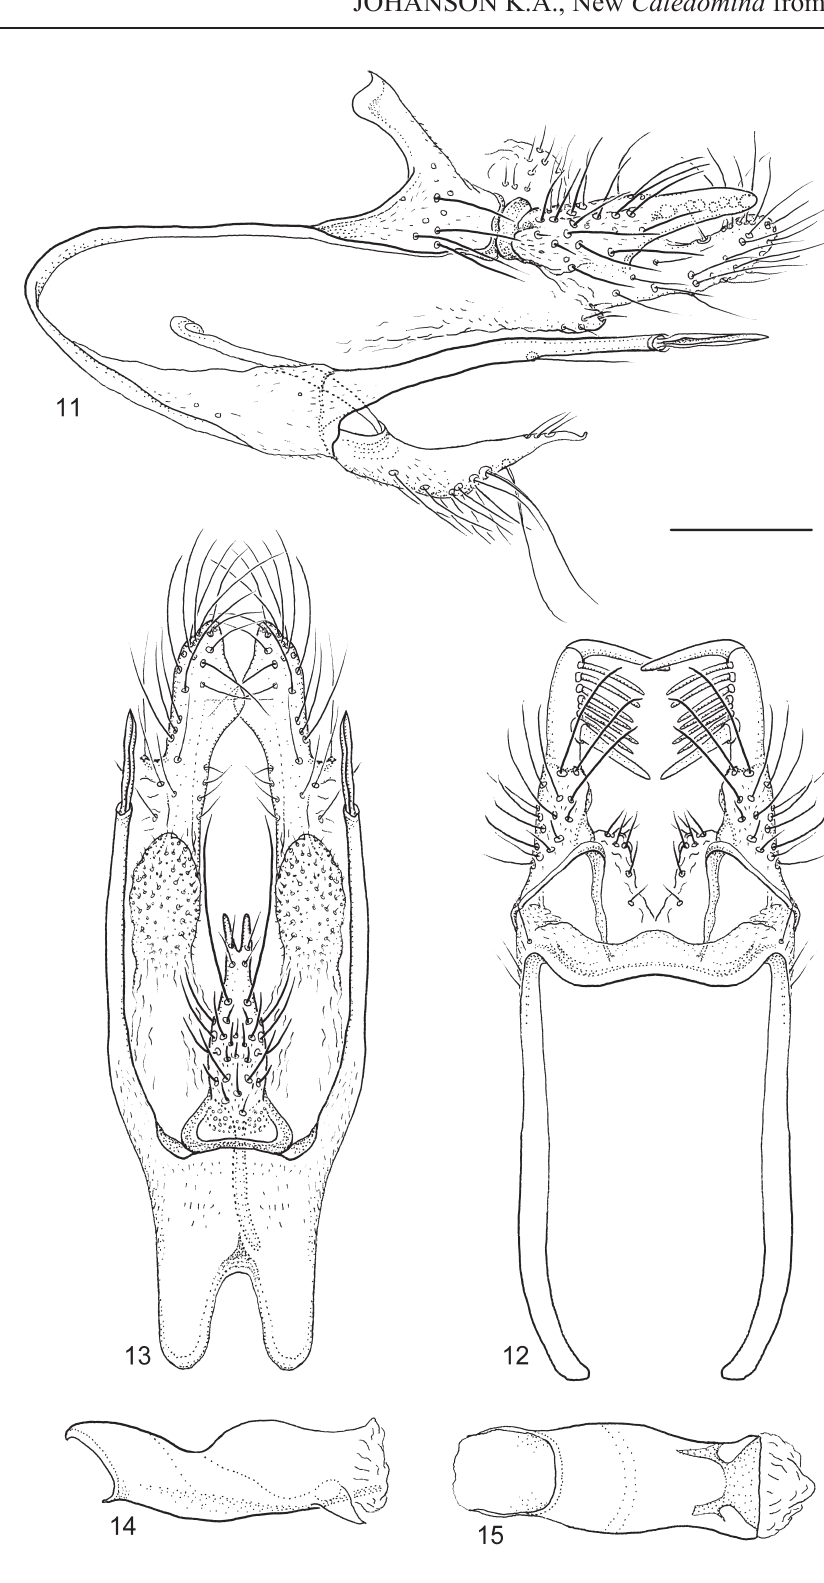
Figs 11–15. Caledomina kohensis sp. nov., holotype, adult ♂. 11 . Genitalia, lateral view. 12 . Genitalia dorsal view. 13 . Genitalia, ventral view. 14 . Phallus, lateral view. 15 . Phallus ventral view. Scale bar = 0.1